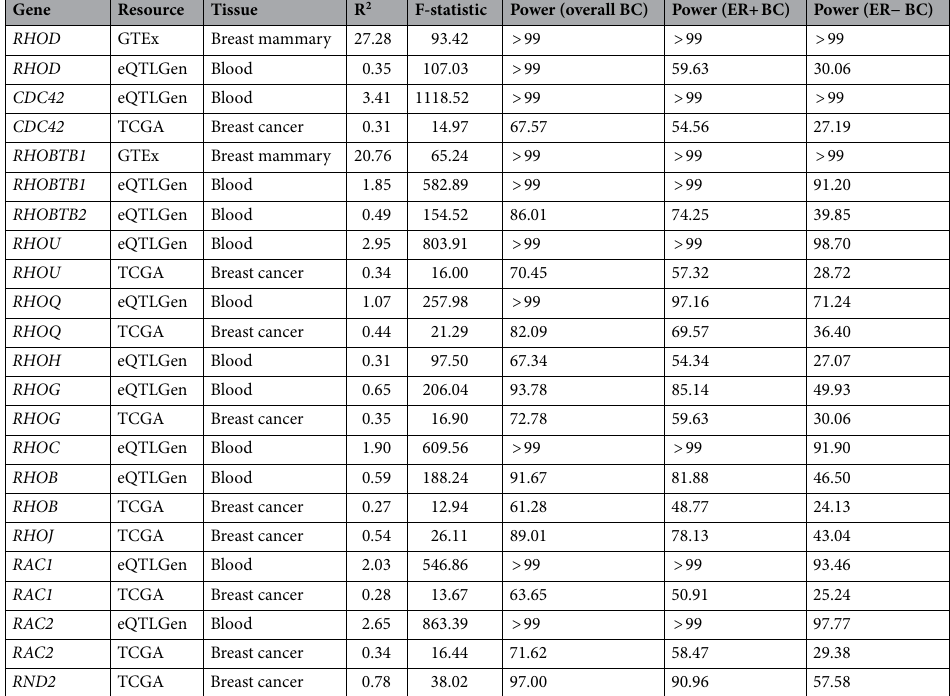
Table 1. Results of power calculation for the main analysis (using top eQTL). BC = breast cancer; R 2 represents the variance explained in the expression level of the gene by the instrument; F-statistic indicates strength of the instrument used for each gene expression (a strong instrument is sometimes defined as an F-statistic > 10); and the Power represents the power to detect an odds ratio of 1.2 (or 0.80) for an association of the expression of gene expression with breast cancer at an alpha-level of 0.05, given the values in the R 2 column and the number of breast cancer cases and